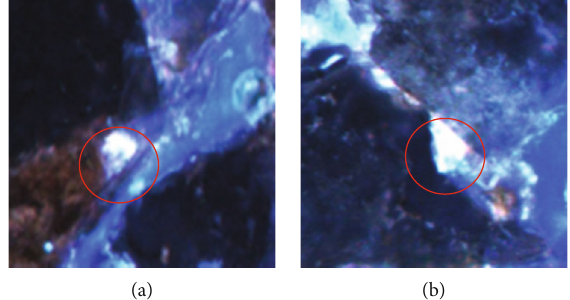
Figure 10: Semibound residual oil. (a) Corner-shaped. (b) Throat-like.